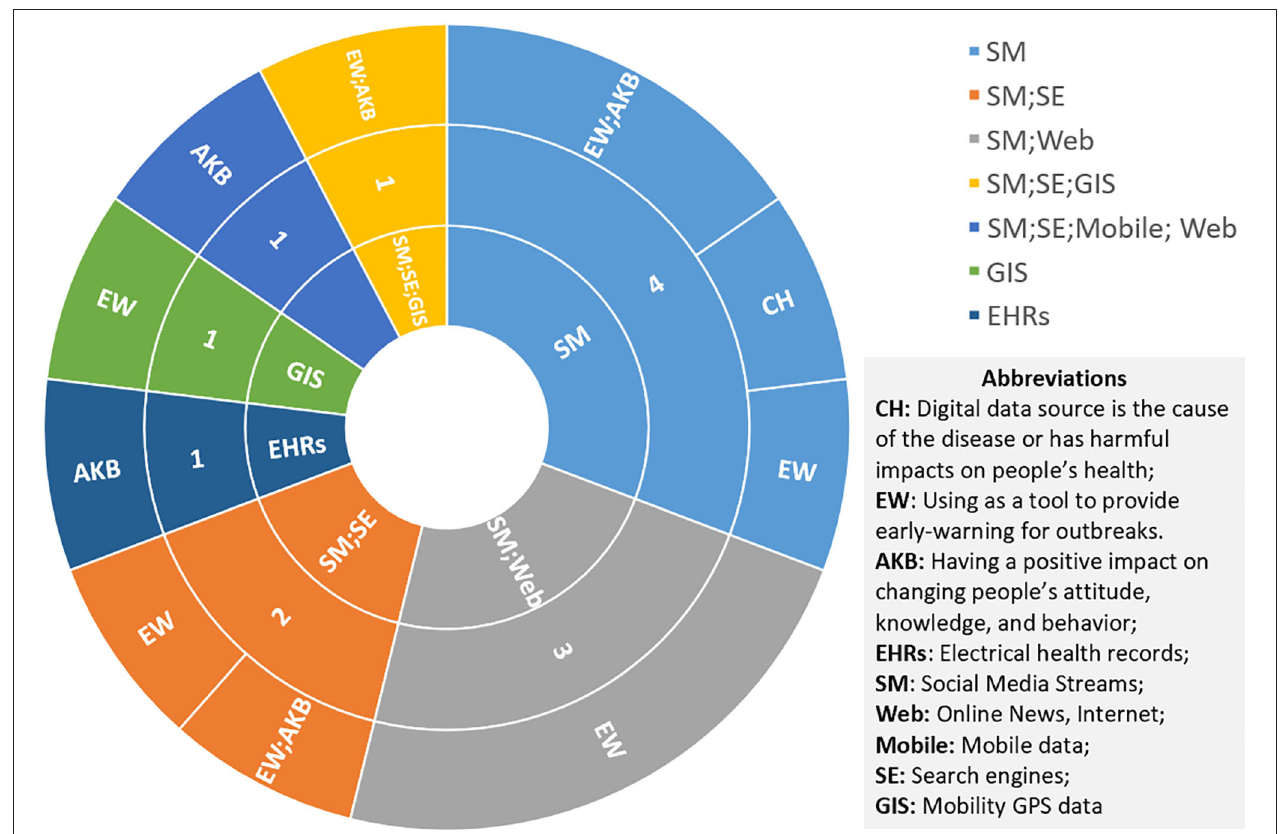
FIGURE 7 | Sunburst chart displaying the impact of each digital source on health